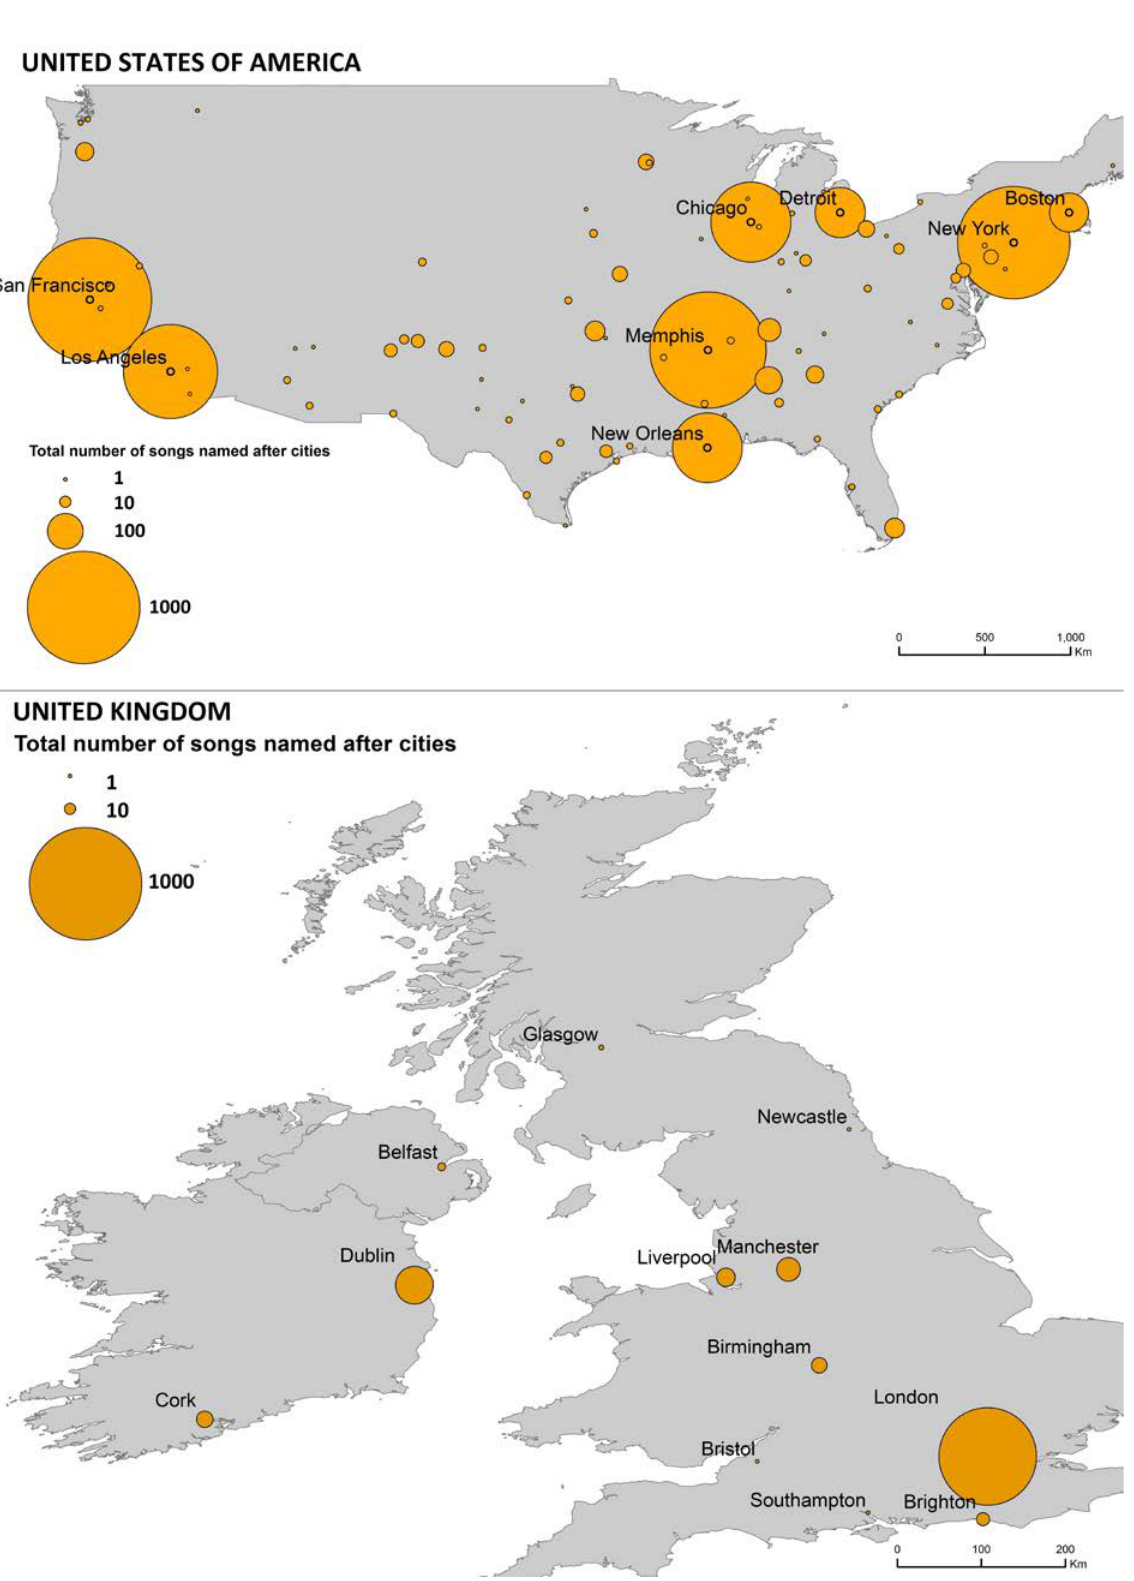
Figure 7: Songs named after cities in USA and UK Source: Own map based on JUCU Database